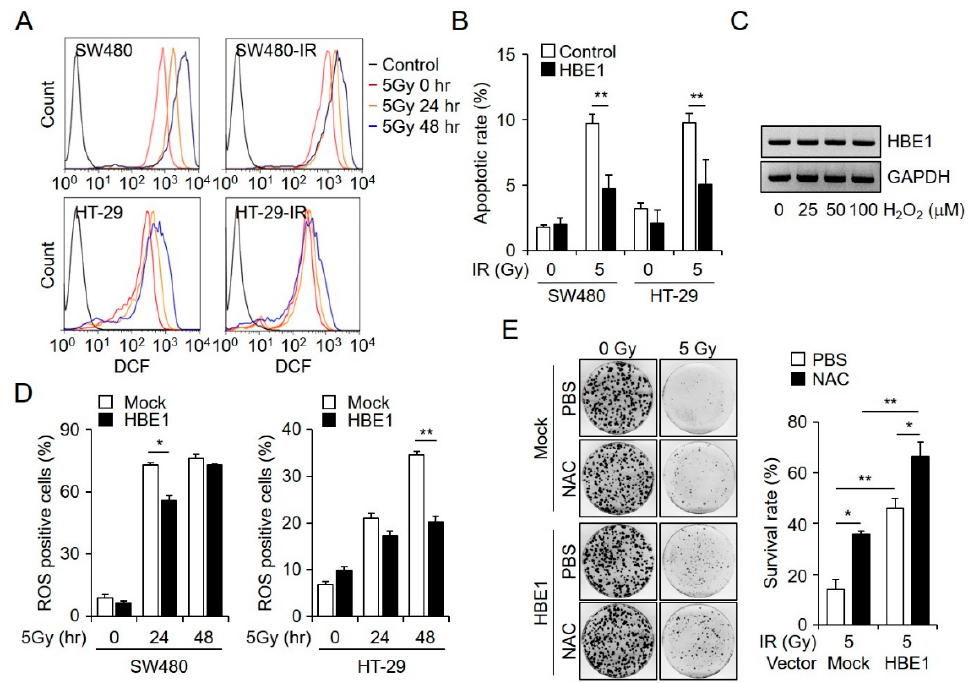
Figure 3. HBE1 expression inhibits radiation-induced cell death by attenuating reactive oxygen species (ROS) generation in colorectal cancer cells. ( A ) CM-H2DCFDA was used to detect radiation-induced ROS generation by flow cytometry at 24 and 48 h after administering 5 Gy of irradiation. ( B ) After the stable transfection of SW480 and HT-29 cells with a control or pCMV-HBE1-overexpression vector, radiation-induced cell death was measured by flow cytometry. After 48 h, both cell lines were irradiated with 5 Gy and apoptotic rates were analyzed by annexin V and PI staining. * p < 0.05, ** p < 0.01. ( C ) RT-PCR data showing the dose-dependent induction of HBE1B mRNA levels in H 2 O 2 -treated SW480 cells. ( D ) Intracellular ROS levels in HBE1-overexpressing SW480 and HT-29 based on CM-H2DCFDA and as measured by flow cytometry, at 24 and 48 h after exposure to 5 Gy of irradiation. * p < 0.05, ** p < 0.01. ( E ) Following the transfection of SW480 cells with a mock or HBE1-overexpression vector, a clonogenic assay was performed after treating the cells with N-acetyl cysteine (NAC) (10 mM) and exposure to 5 Gy irradiation. The left panel shows a representative clonogenic plate and the right panel depicts the survival rate. All data shown are the means ± SD of three independent experiments. * p < 0.05, ** p < 0.01 versus the control.